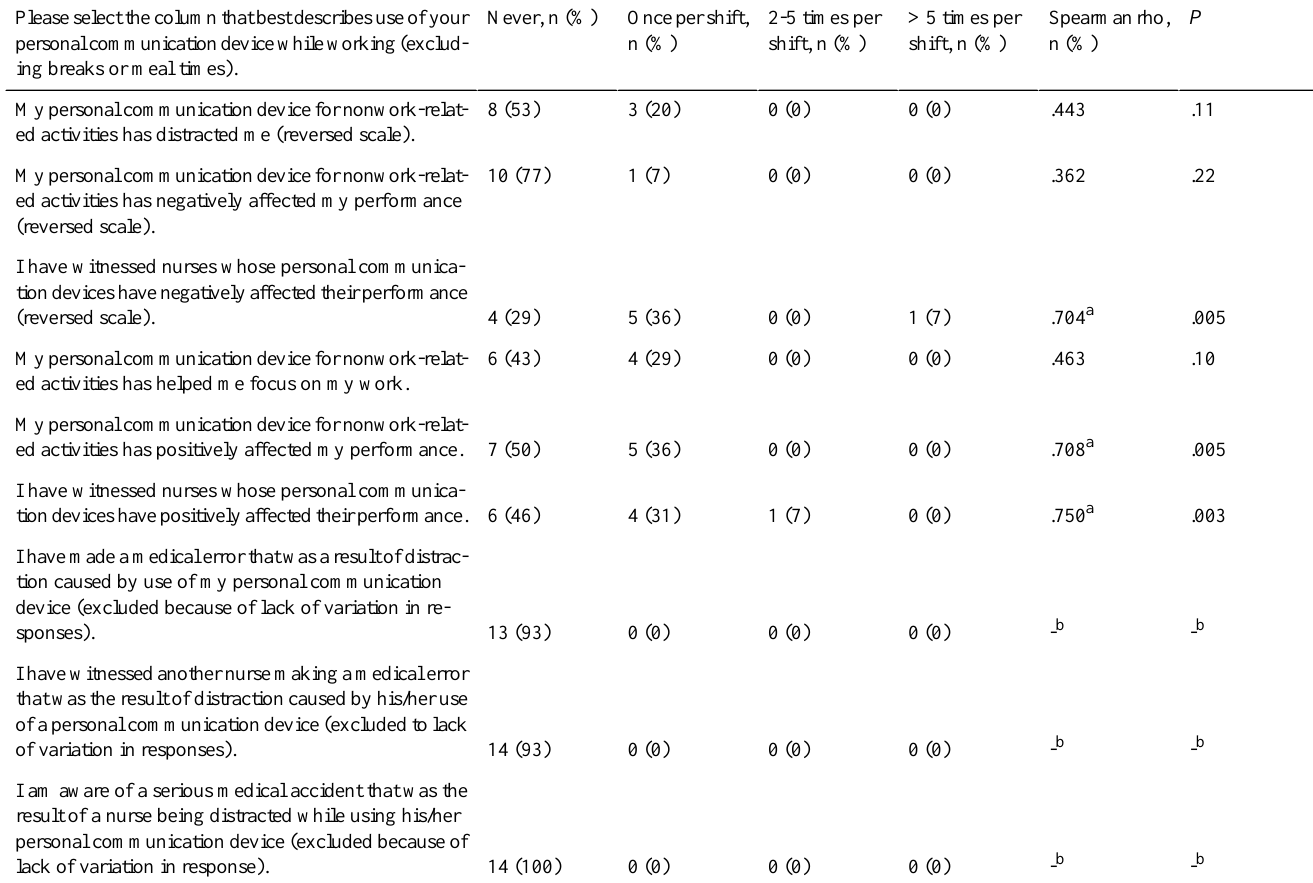
Table 3. Respondents with the same answers to both online pilot surveys for Group 2: performance scale.